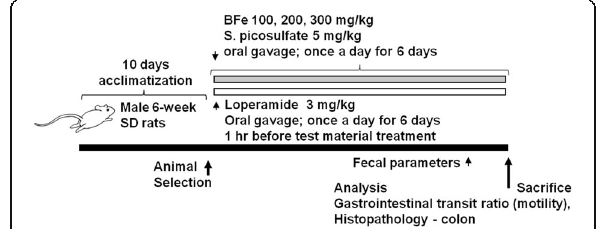
Fig. 1 Experimental designs used in this study. FBe: Triple fermented barley extracts, test material; LP: Loperamide; SP: Sodium